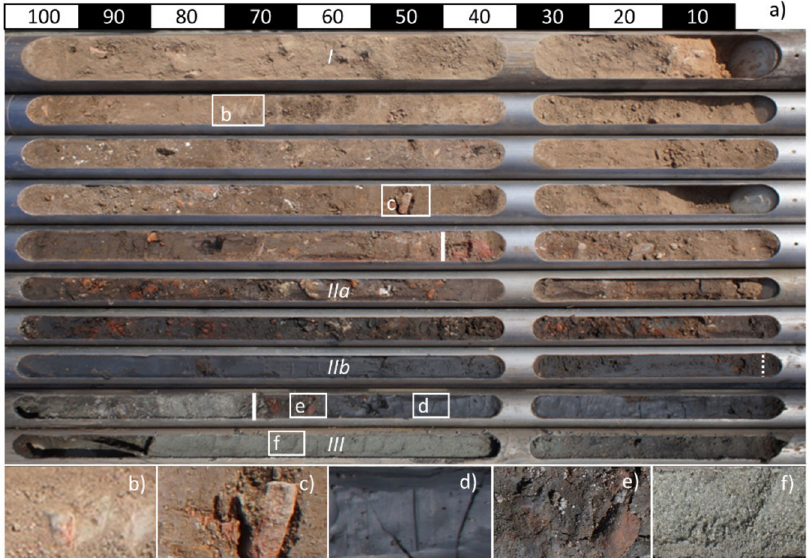
Figure 3. ( a ) Core stratigraphy of E7 showing the three major lithologic units: anthropogenic surface layer ( unit I ), clayey fluvial/limnic sediments with a high content of cultural debris ( unit II a), clayey fluvial/limnic sediments with a low content of cultural debris ( unit II b), and sands of fluvial origin ( unit III ). ( b , c ) Pottery fragments; ( d ) Clayey fluvial/limnic sediments; ( e ) Pottery fragments from a period before the 25th dynasty (i.e., before c. 728 BCE); ( f ) Sands of fluvial origin. Photos: J. Trappe